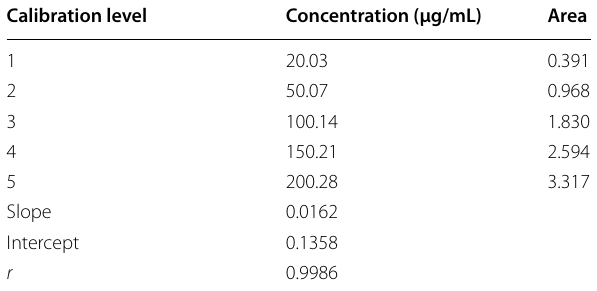
Table 3 Risk of error in accuracy results (limit 10%